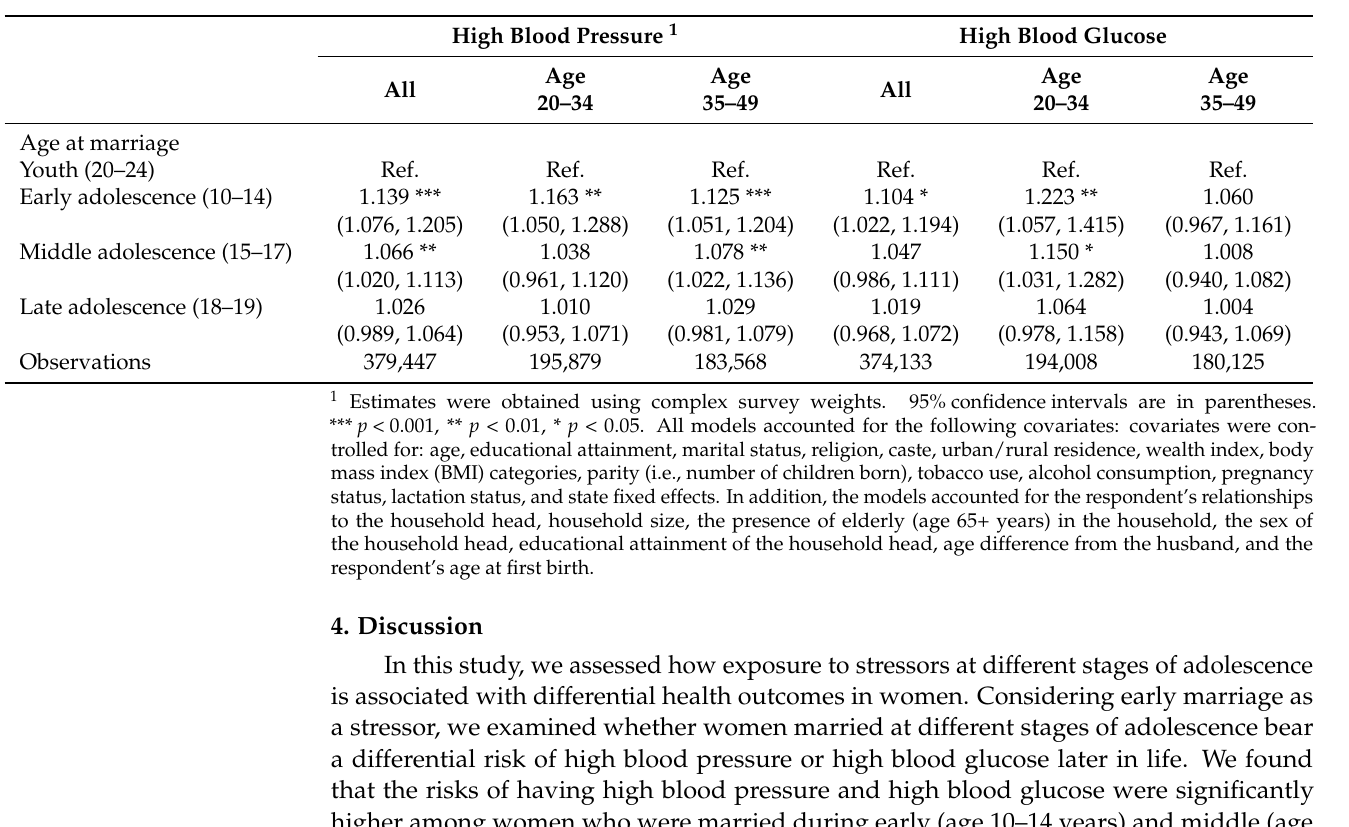
Table 4. Adjusted odds ratios in favor of having high blood pressure and high blood glucose by age at marriage with controls for potential mediating